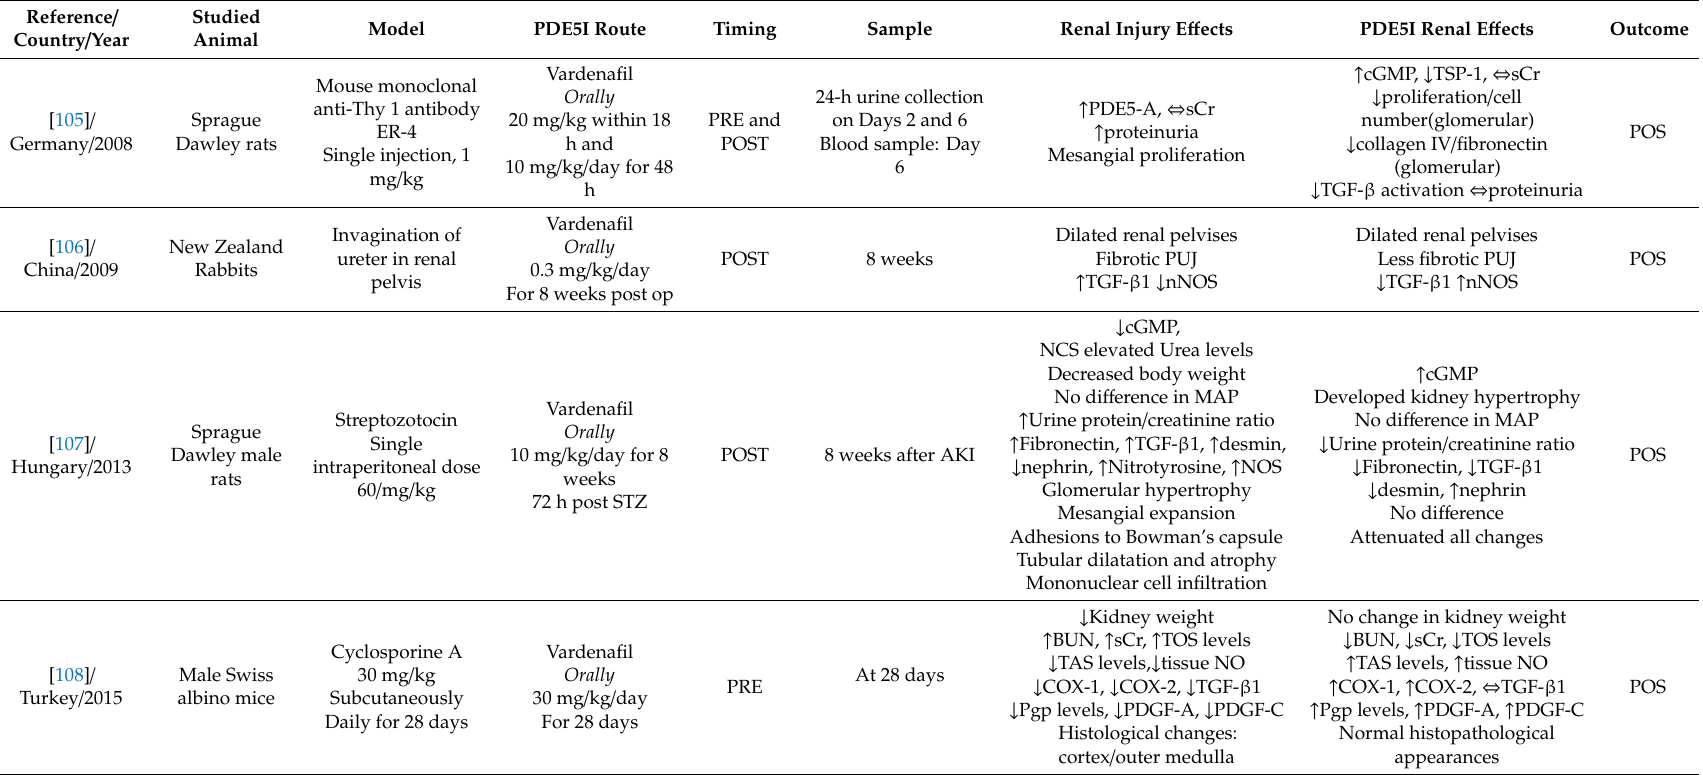
Table A4. Animal studies evaluating the potential reno-protective e ff ects of